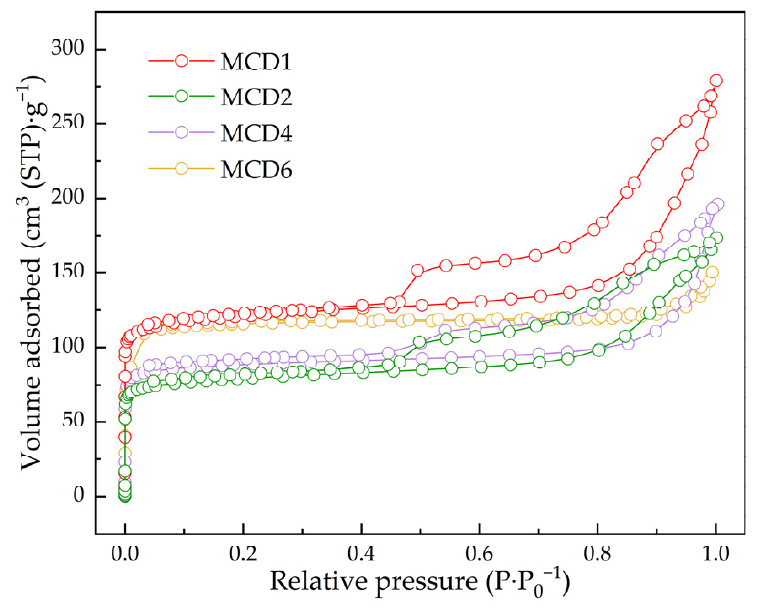
Figure 4. N 2 adsorption–desorption isotherms of